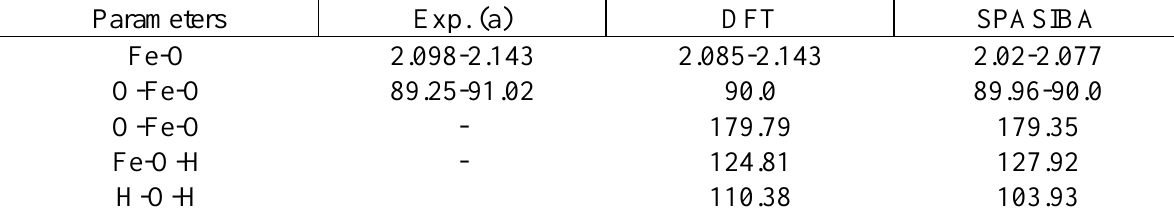
Table 5a . Structural parameters obtained from DFT geometry optimization and empirical